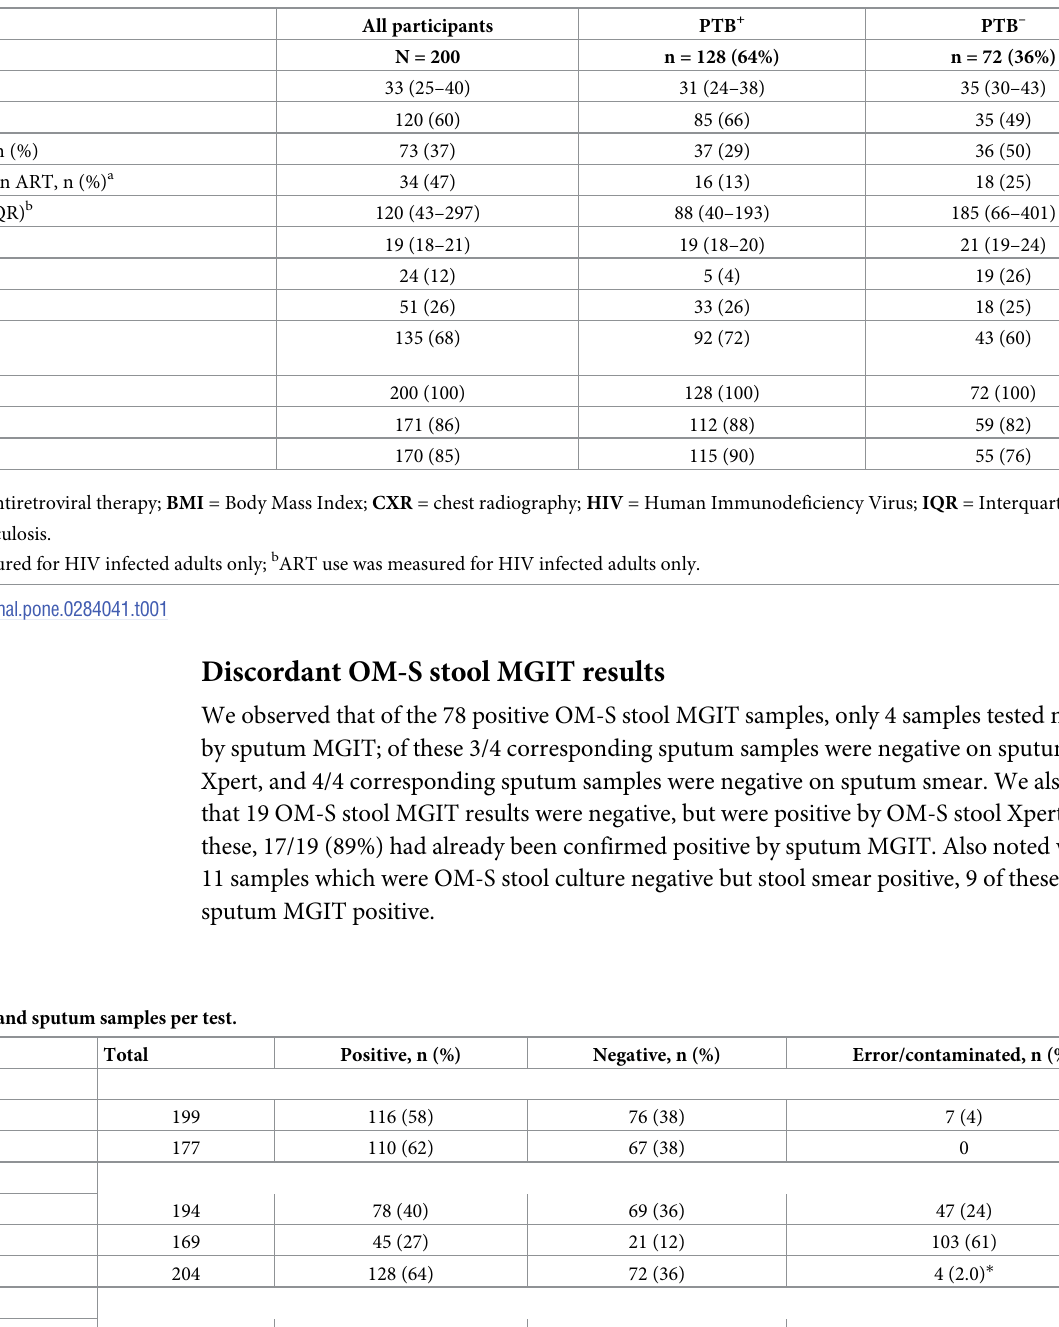
Table 1. Demographic characteristics between bacteriologically confirmed TB patients and non-TB patients.